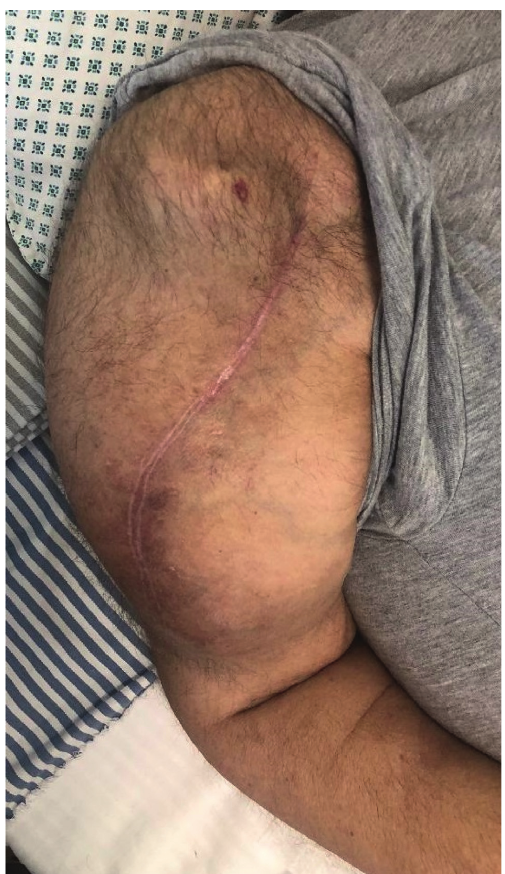
Figure 2: Left upper arm tumor.